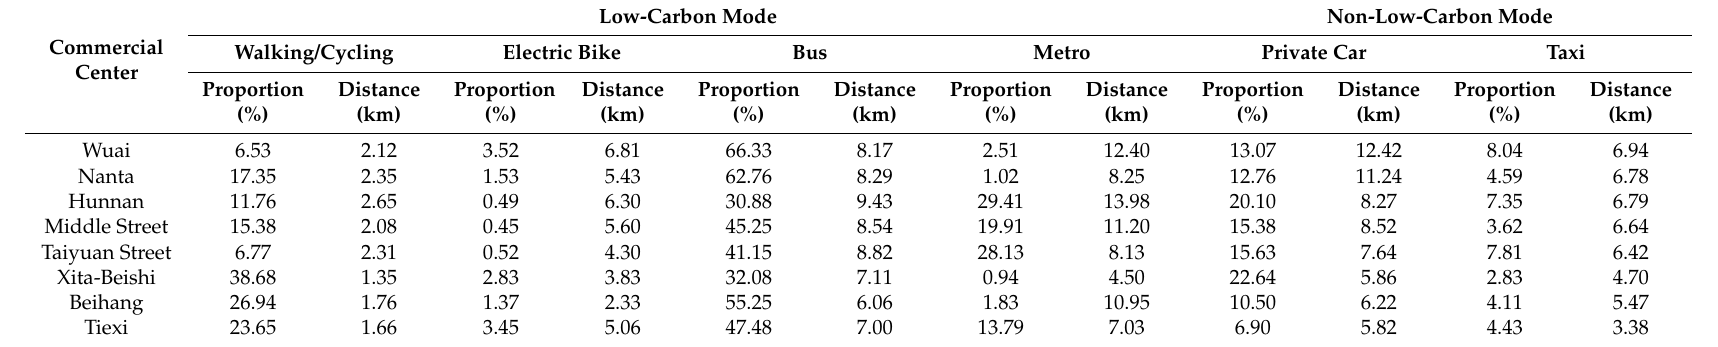
Table 2. Travel behavior data for shoppers at eight commercial